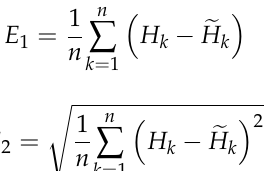
Figure 22. Precision validation of our method. The green dot line is the ground truth; the red solid line is the detection result of our method in this paper. However, when the illumination conditions are so bad that both the trees and the shade of the trees on the bank are dark, it is difficult to judge where the waterline lies, and the detected waterline of our method in this paper has some errors at some positions. The experimental result can be seen in Figure 23. Therefore, in the future work, we will research deeply to improve the performance of our waterline detection method.